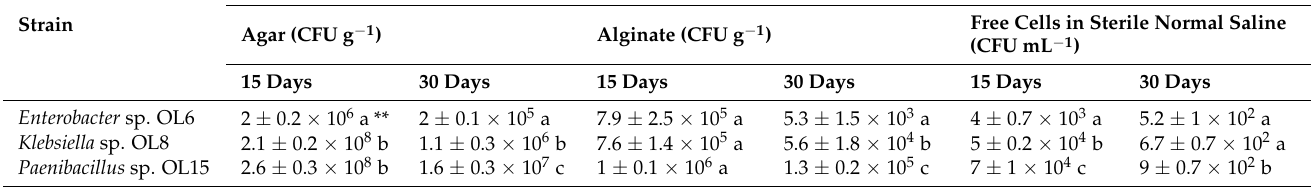
Table 2. Number of surviving cells of free and immobilized cells with respect to strain, immobilization material, and incubation period.